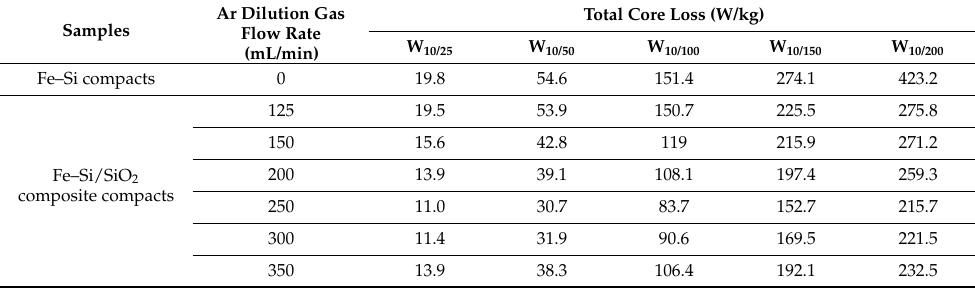
Total Core Loss (W/kg)